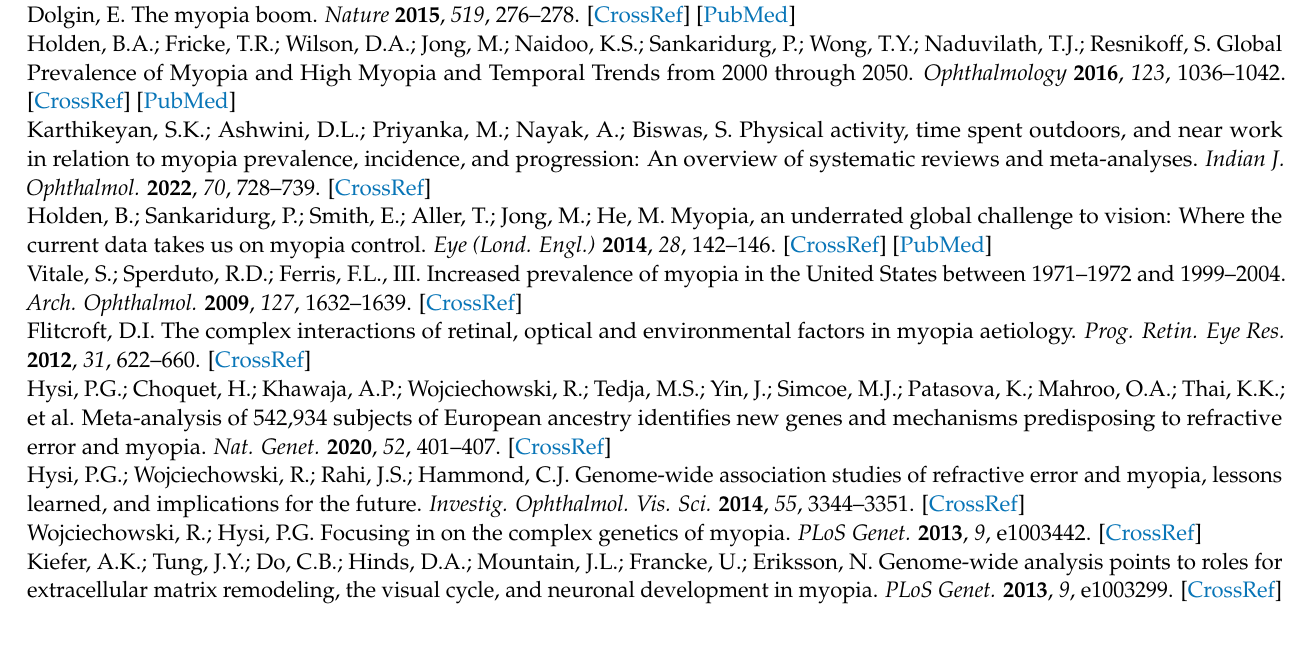
Figure S2, Spherical equivalent refraction versus OPN1LW gene haplotype ranks; Table S1, Baseline characteristics of eye-glasses study participants; Table S2, Splicing assay